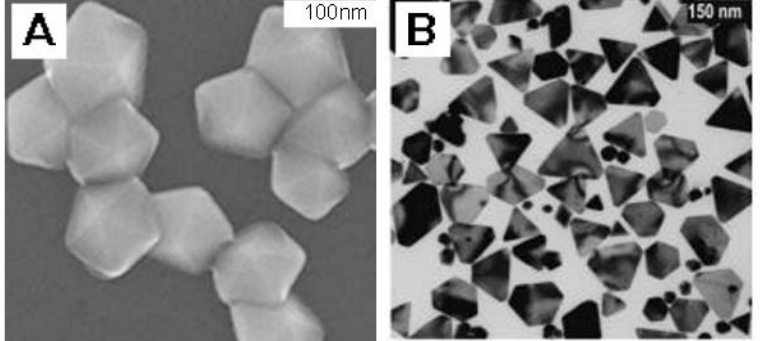
Figure 2. Electron microscopy images of single-crystal Ag nanocrystals: ( A )